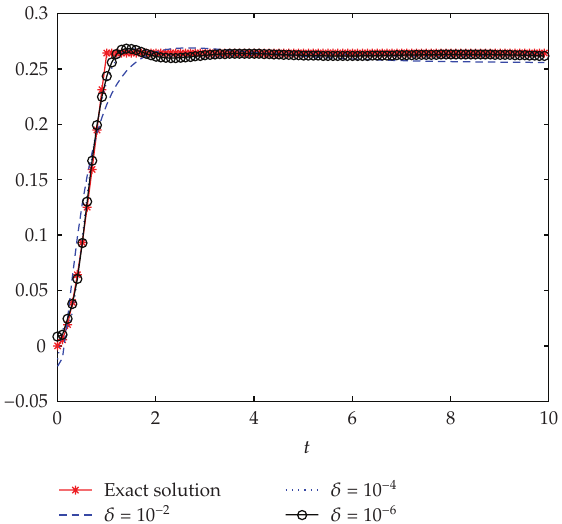
Figure 7: Example 3.7: the stability of the approximate solution.